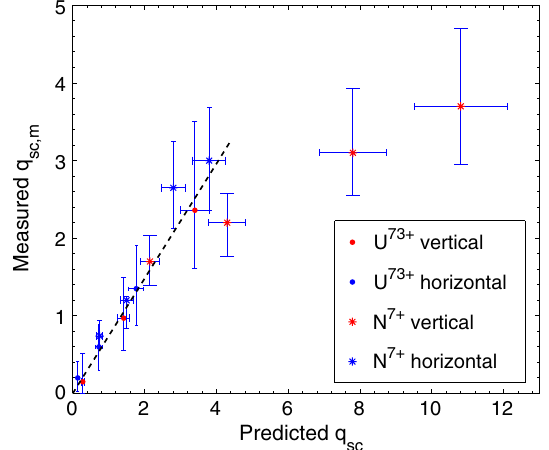
FIG. 16. Combining the results from Figs. 12–15, a plot of predicted q sc using Eq. (4) against measured q sc using the distance between modes k ¼ 0 and k ¼ 1 is obtained.